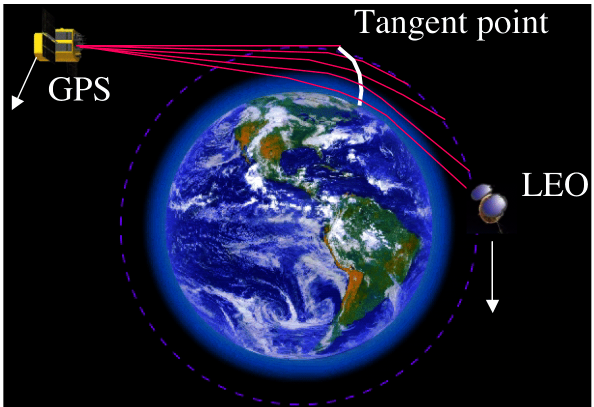
Fig. 2. Geometry of RO limb scanning technique. As the Low- Earth Orbiting (LEO) satellite carrying a GPS receiver rises or sets behind Earth, a series of scans of Earth’s atmosphere is obtained. The bending of the radio waves is determined through precise mea- surements of the phase changes and used to compute bending angle, refractivity and other products at high vertical resolution.